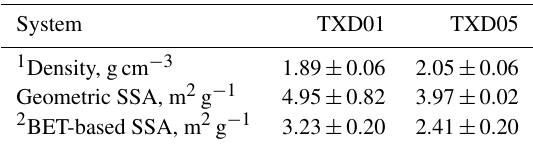
Table 3. Properties of OLLF samples: TXD01 and TXD05. System TXD05